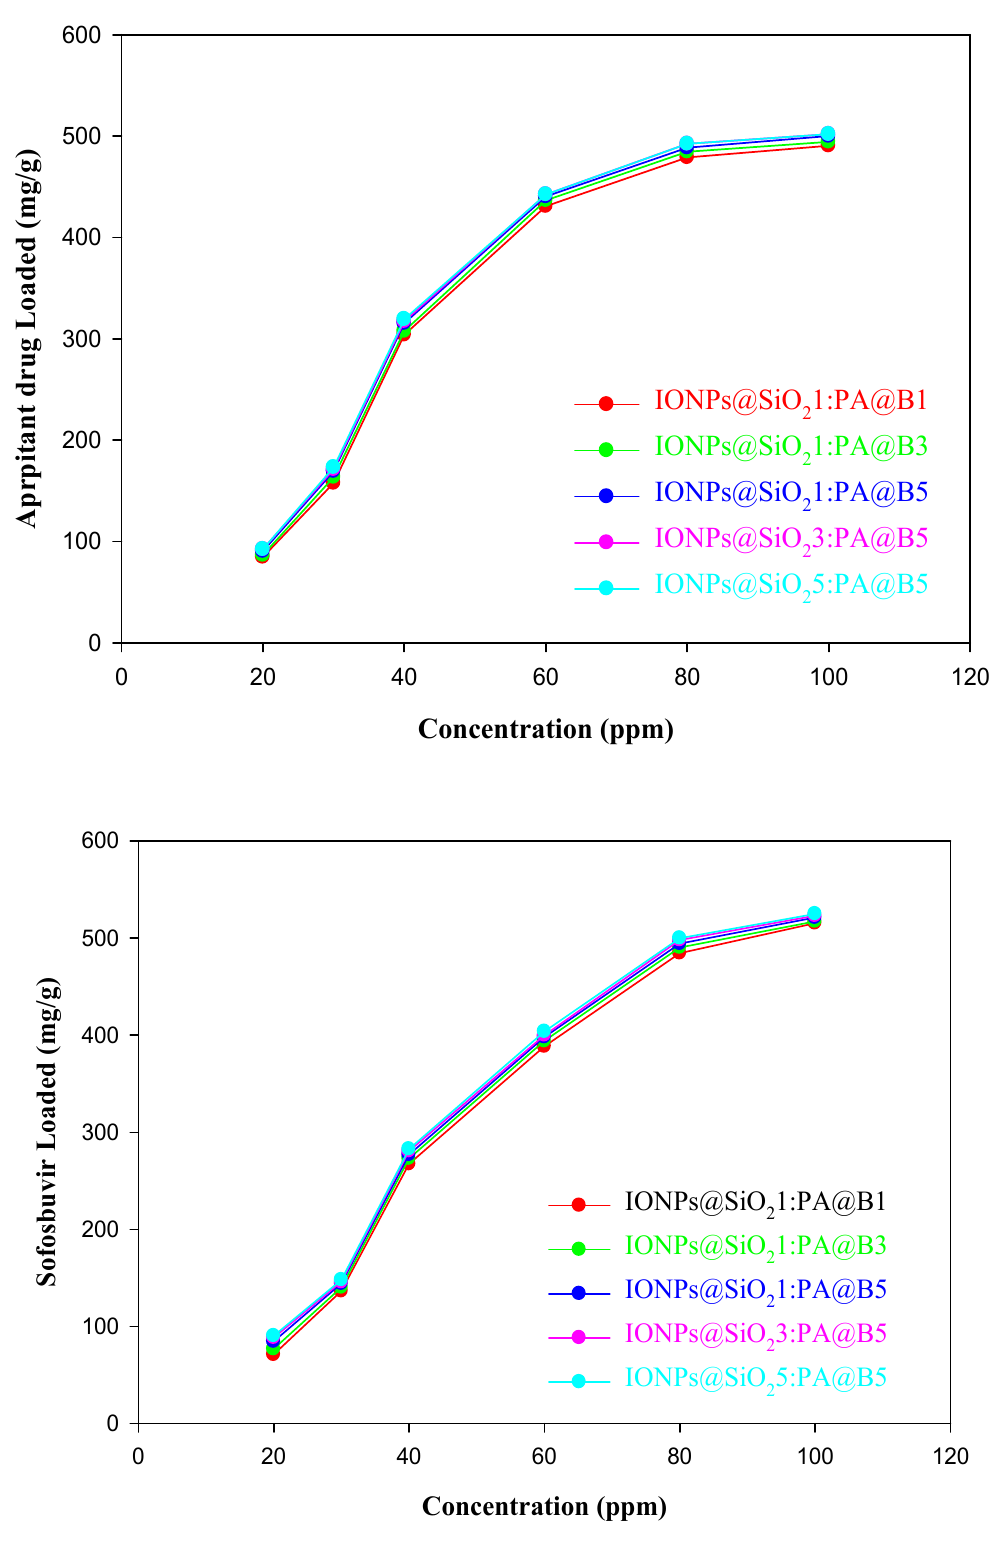
Figure 10. Loading of drugs into the fabricated MCM-PA@B at different concentrations: aprepitant ( upper ); sofosbuvir ( lower ). The release of the drugs aprepitant and sofosbuvir at various time intervals is shown in Figure